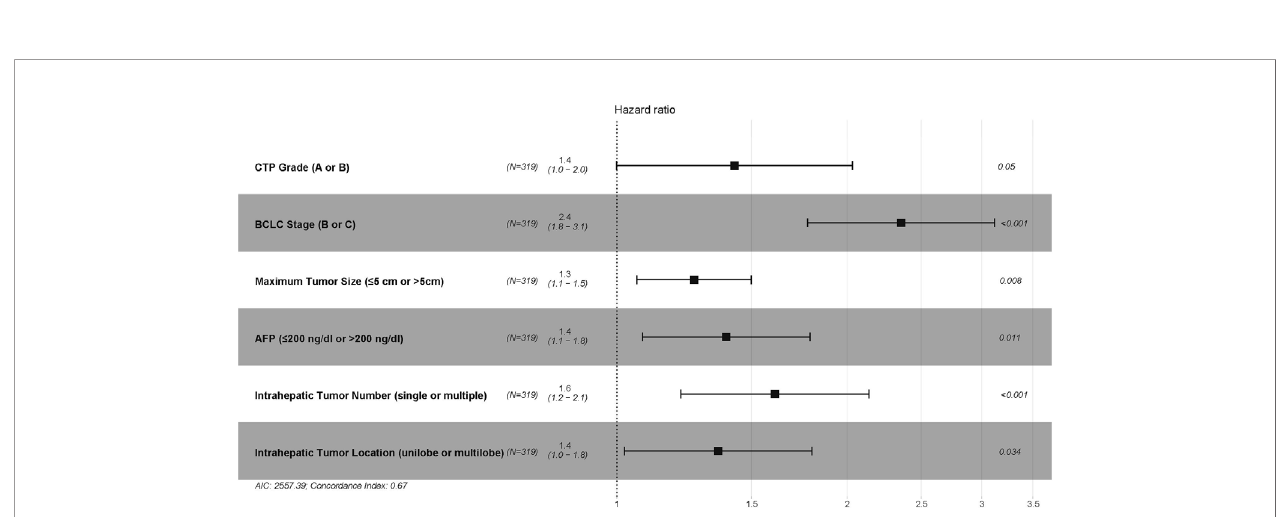
FIGURE 3 | The CTP-based multivariate Cox proportional hazards regression analysis of risk factors associated with overall survival in the training cohort. CTP, Child – Turcotte – Pugh; BCLC, Barcelona Clinic Liver Cancer; AFP, alpha-fetoprotein.